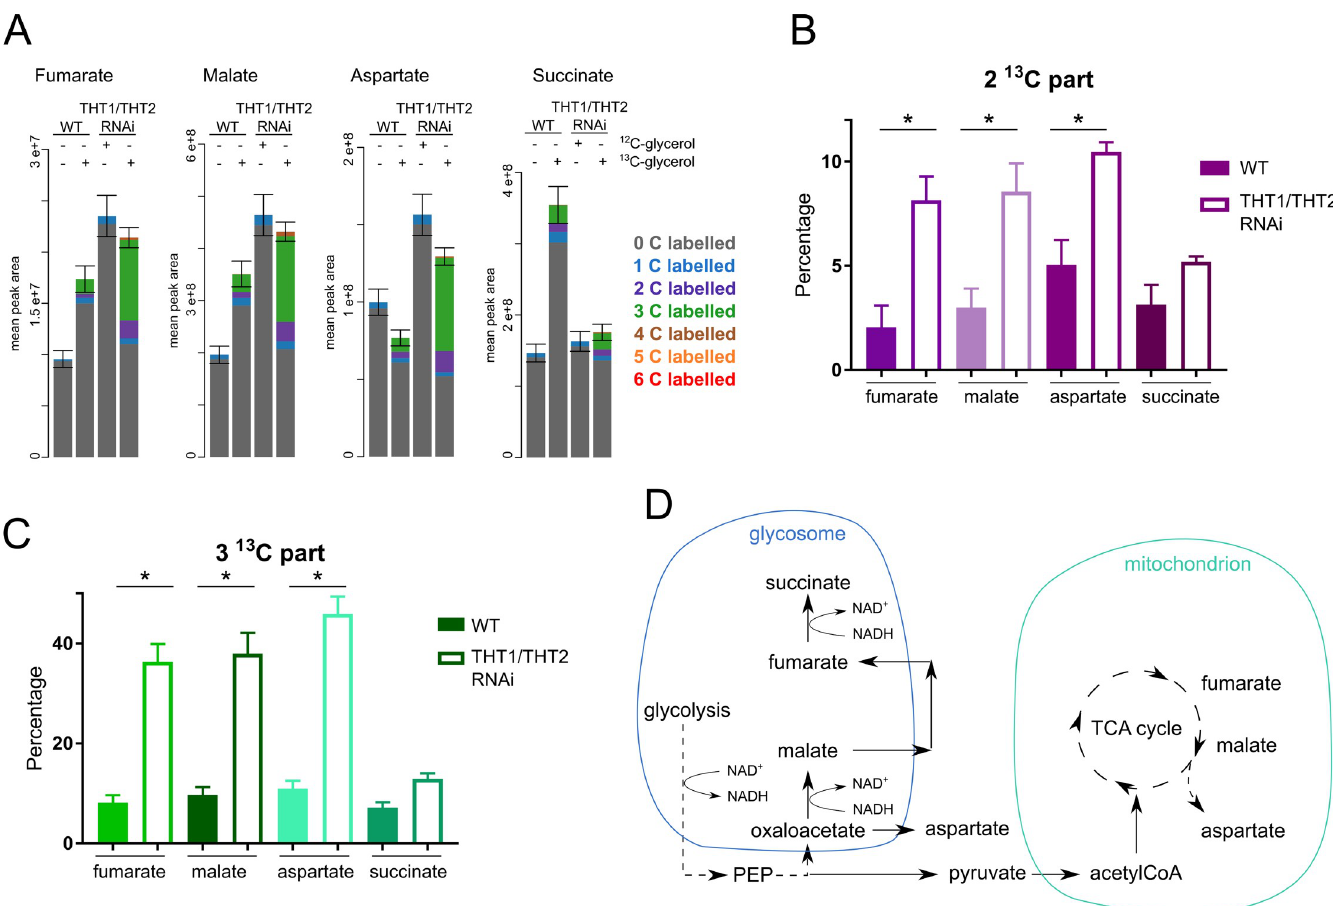
Fig 7. Metabolic adjustments of trypanosomes growing on glycerol. (A) Profiles of fumarate, malate, aspartate and succinate as detected by LC-MS metabolomics. Samples and visualization as in Fig 4B. (B) Proportion of these metabolites with two 13 C labelled carbons in WT and THT1/THT2 RNAi cells, � p < 0.001. (C) Proportion of these metabolites with three 13 C labelled carbons in WT and THT1/THT2 RNAi cells, � p < 0.001. (D) Scheme indicating potential explanation for the labelling patterns observed. The 13